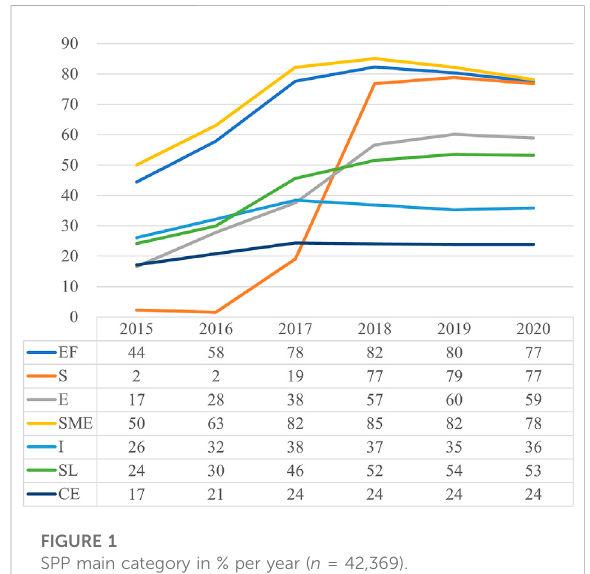
FIGURE 1 SPP main category in % per year ( n = 42,369).